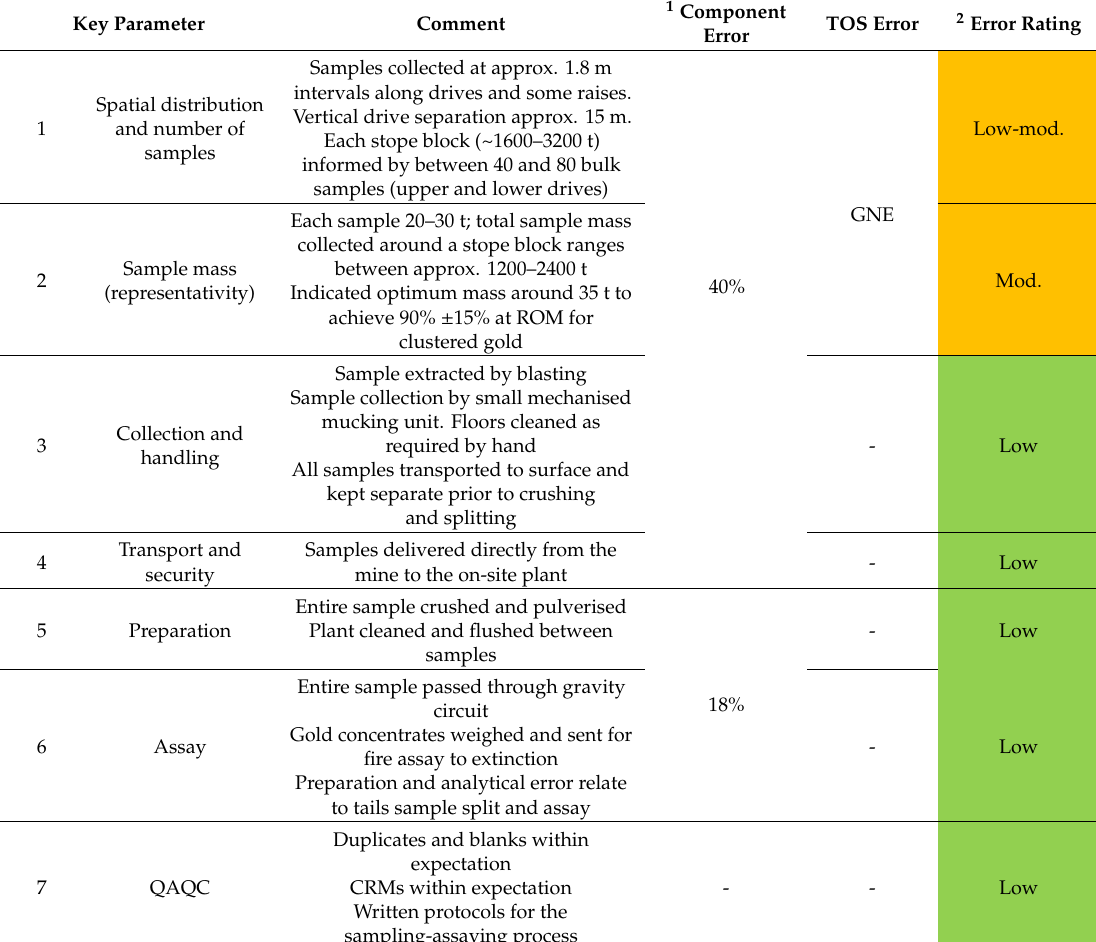
Table 27. Risk review of the San Christina bulk sampling programme used during production for resource